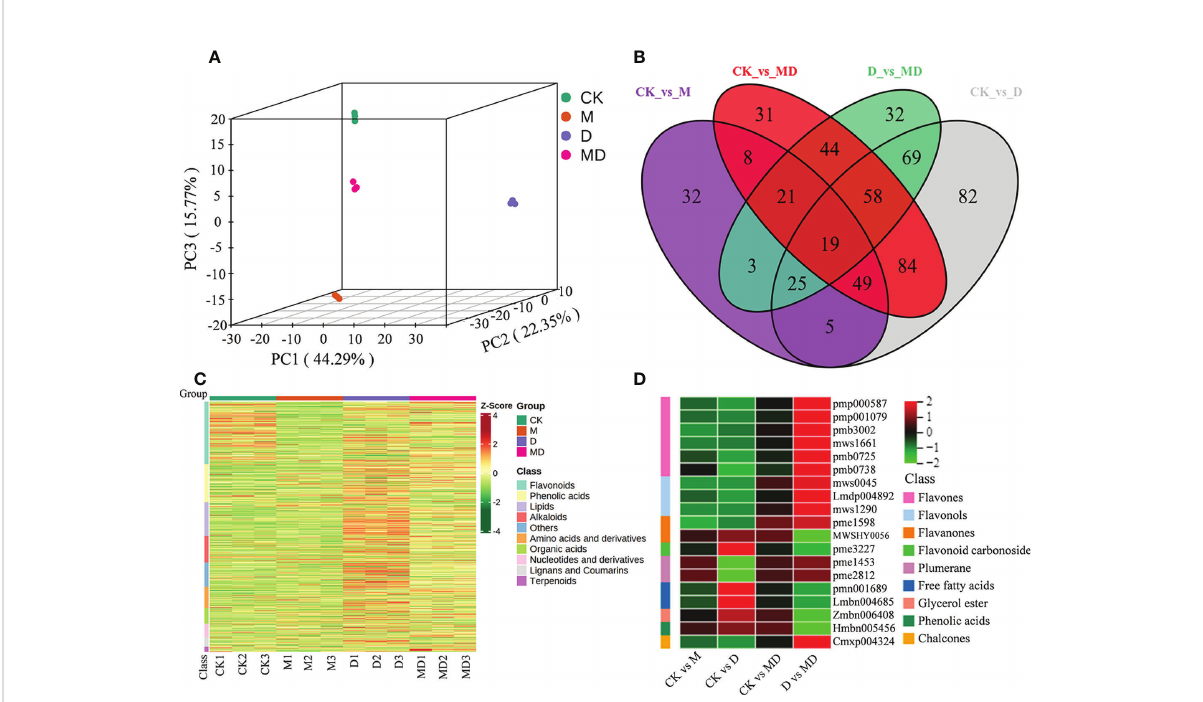
FIGURE 4 Metabolites analysis of A. mongolicum seedlings under drought stress. (A) PCA analysis of metabolites. (B) Venn diagram of DEMs. (C) Heat map visualization of metabolites. Red indicates high abundance, whereas relatively low-abundance metabolites are shown in green (color key scale at the right of the heat map). (D) Heat map analysis of common DEMs in “ CK vs. MD, ” “ CK vs. D, ” “ CK vs. MD, ” and “ D vs. MD. ”